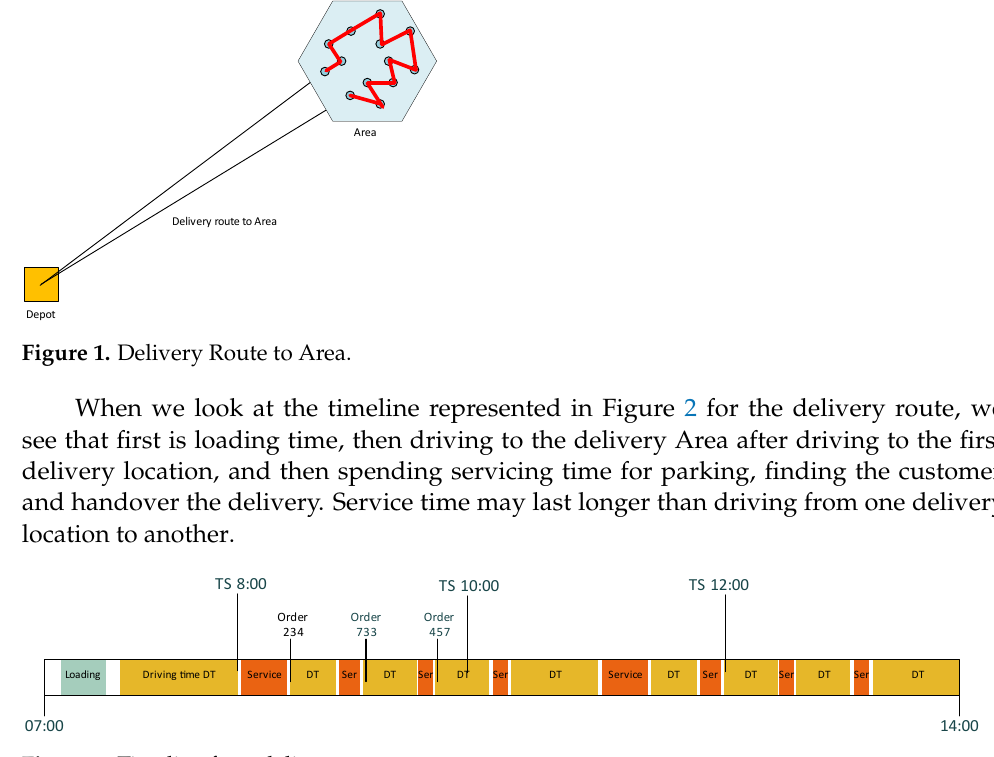
Figure 2. Timeline for a delivery route.